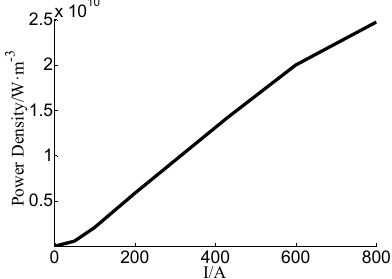
Figure 11. Power density variation with current intensity I.